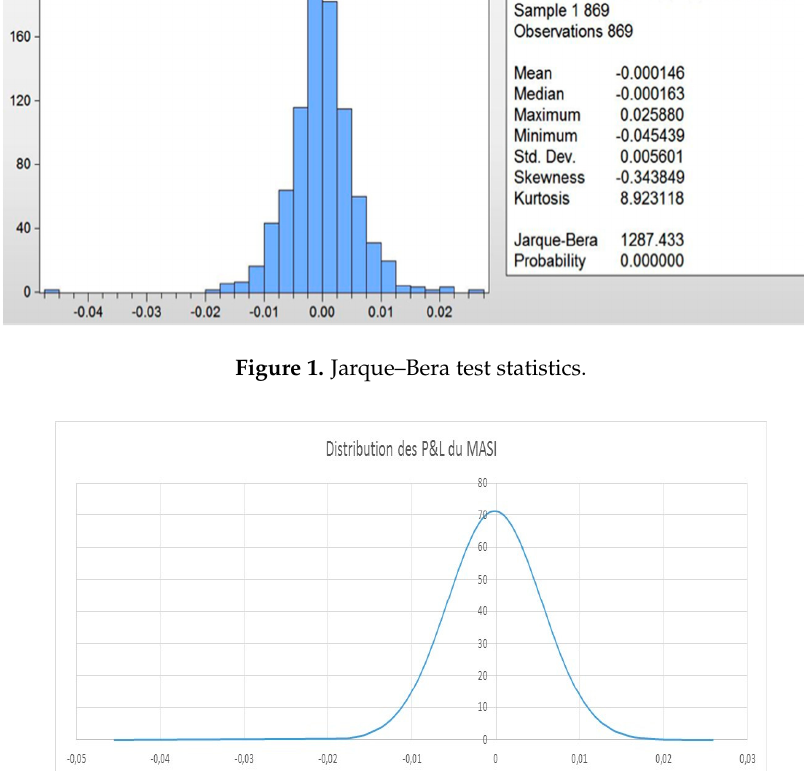
Figure 2. Moroccan All Shares Index (MASI) profits and losses (P&L) distribution.